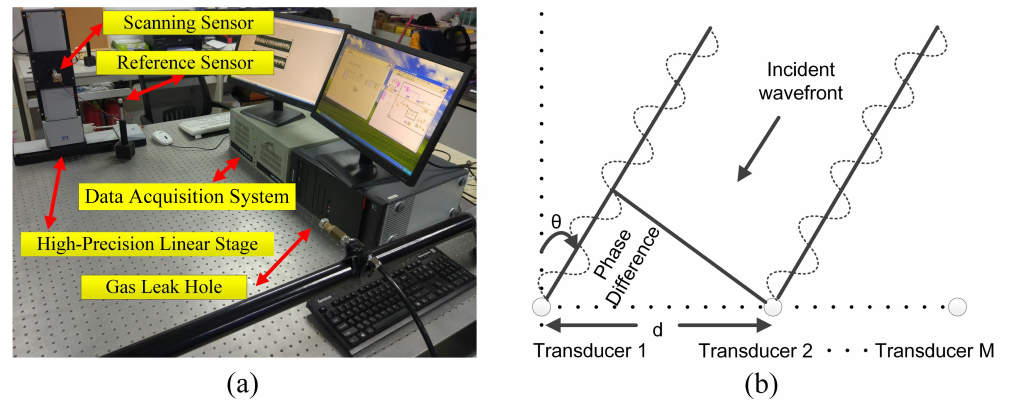
Figure 2. ( a ) Experimental apparatus. ( b ) Schematic diagram of the linear array receiving a signal.